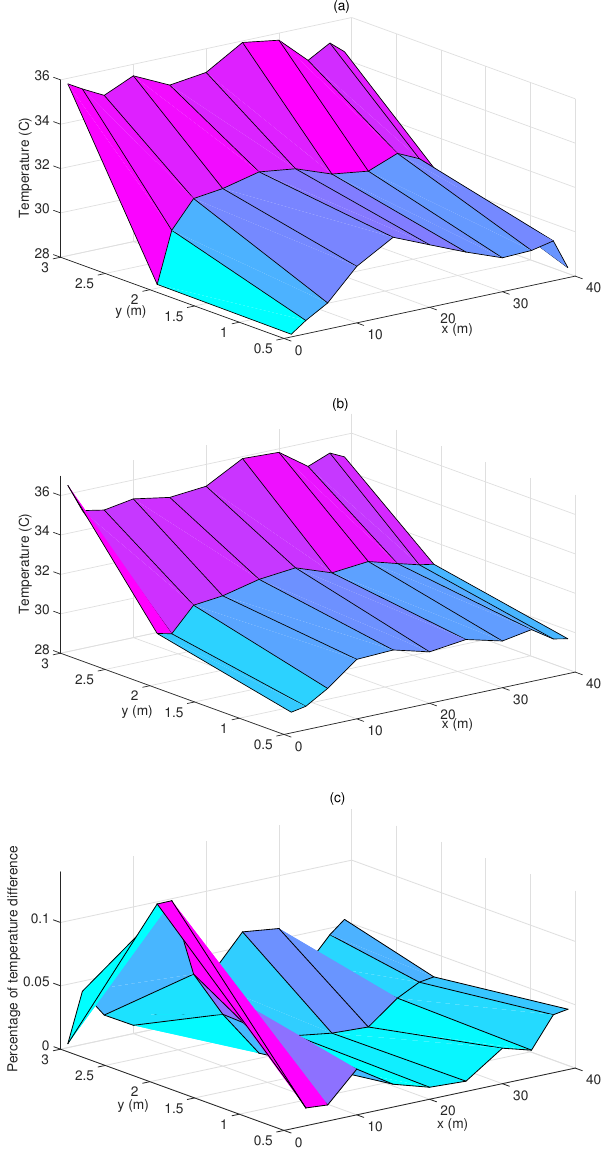
Figure 8. Results of 2D temperature measurements: ( a ) natural ventilation, ( b ) mechanical ventilation, ( c ) percentage of temperature difference between experiment and